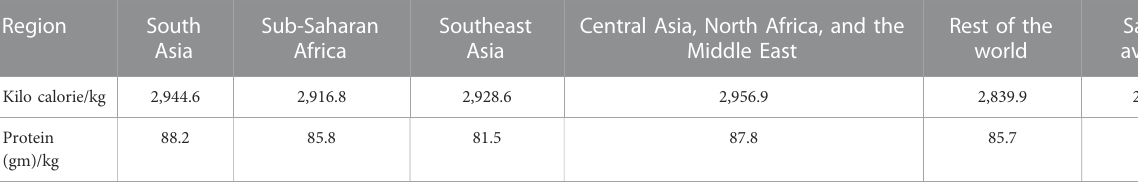
Rest of the Sample world average